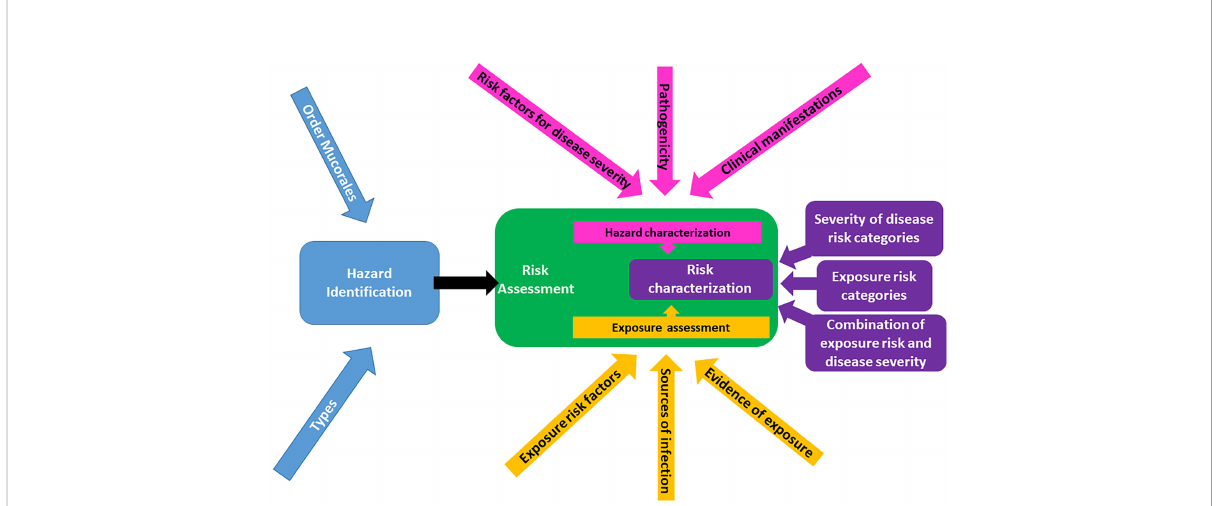
FIGURE 2 Structural framework for a qualitative risk assessment of mucormycosis in harbor porpoises, demonstrating the three major steps of the assessment: hazard identi fi cation (blue), risk assessment (green), and risk characterization (purple). Adapted from Food and Agriculture Organization of the United Nations/World Health Organization (2011) and Sharma et al.